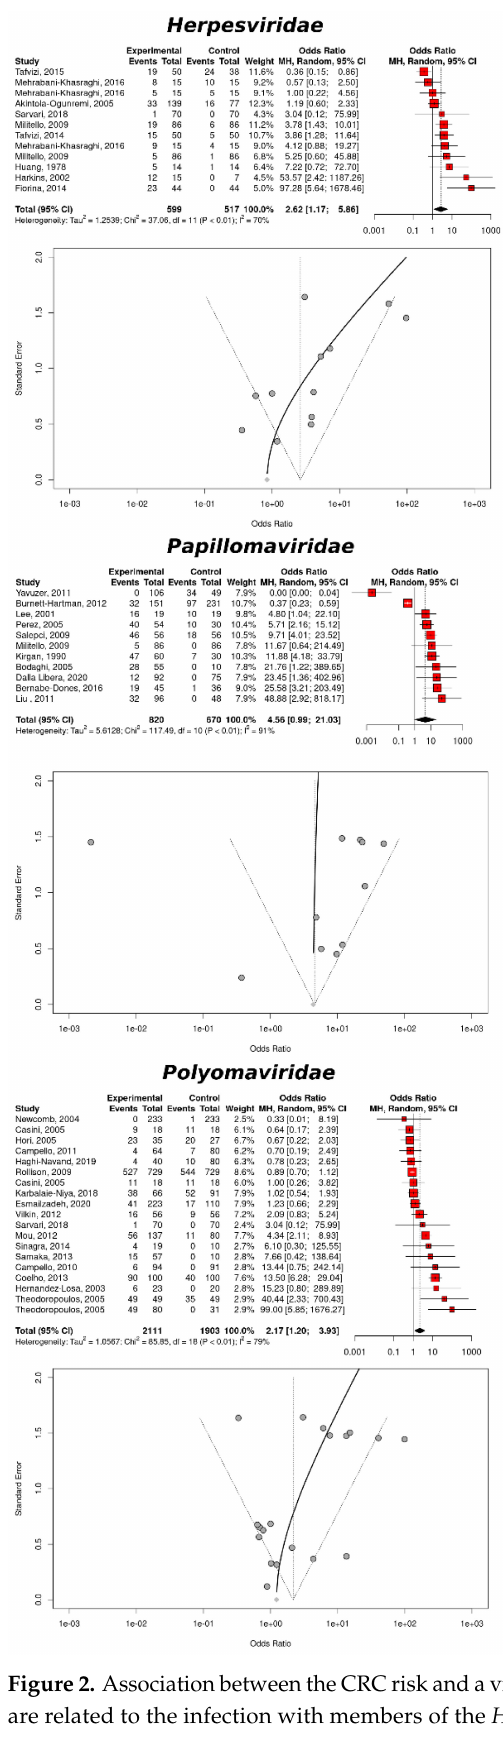
Figure 2. Association between the CRC risk and a viral infection. The upper, middle, and lower panels are related to the infection with members of the Herpesviruses , Papillomaviridae , and